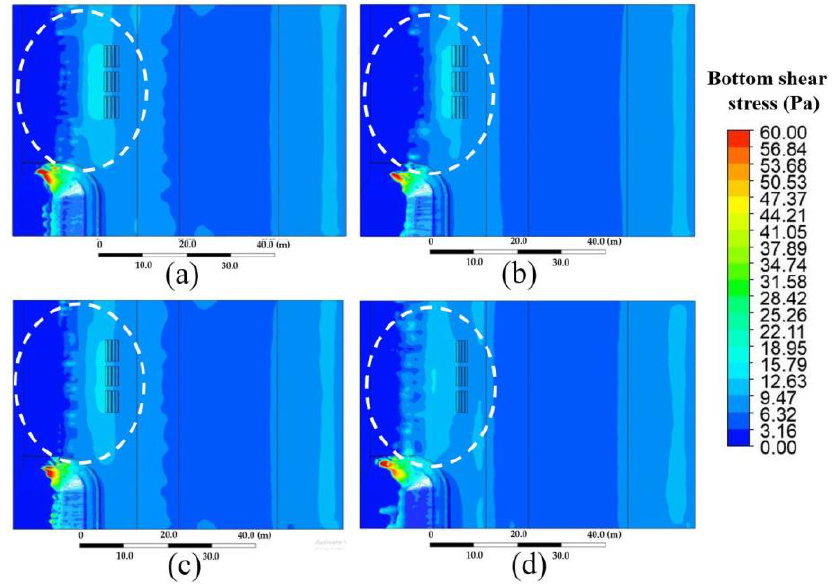
Figure 14. The bottom shear stress of ( a ) P1/10 °, ( b ) P1/15° , ( c ) P1/30° , and ( d ) P1/45 °.